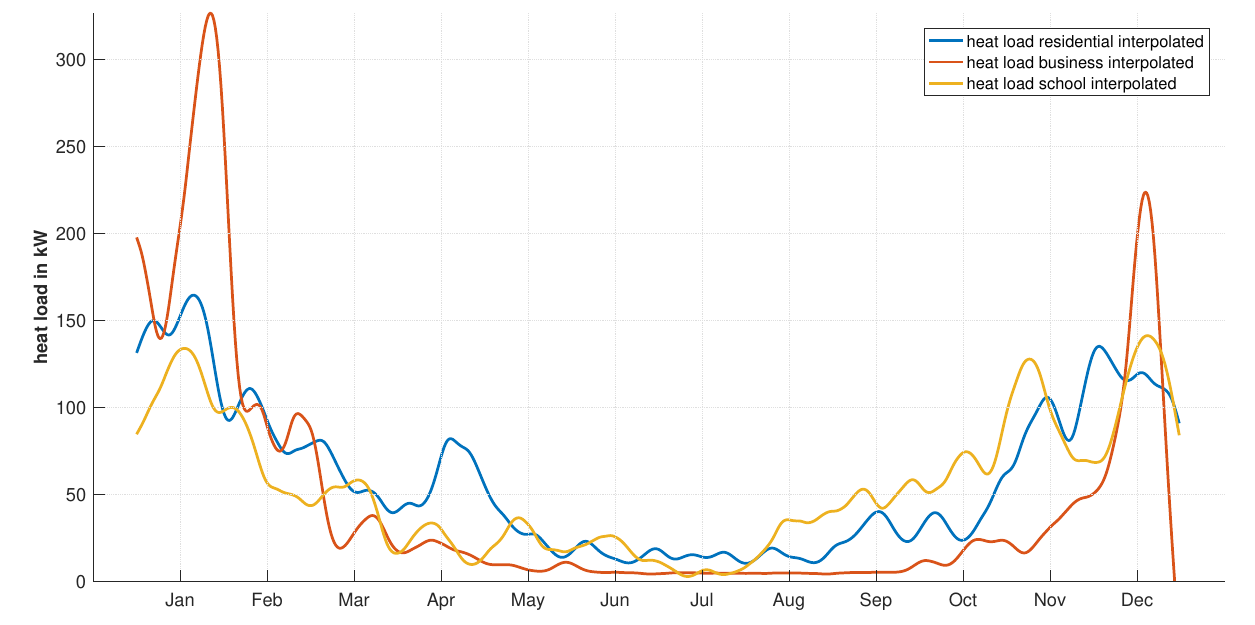
Figure A2. Interpolated heat load of buildings.